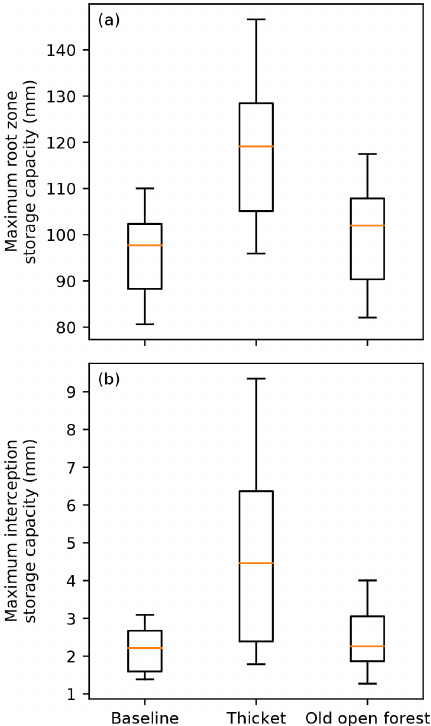
Figure 4. Box plots showing maximum (a) root zone storage ca- pacity and (b) interception storage capacity, for the baseline and forest regeneration scenarios. The median is shown by the orange line, while the box extends from the lower to upper quartiles. The 5th and 95th percentiles are given by the